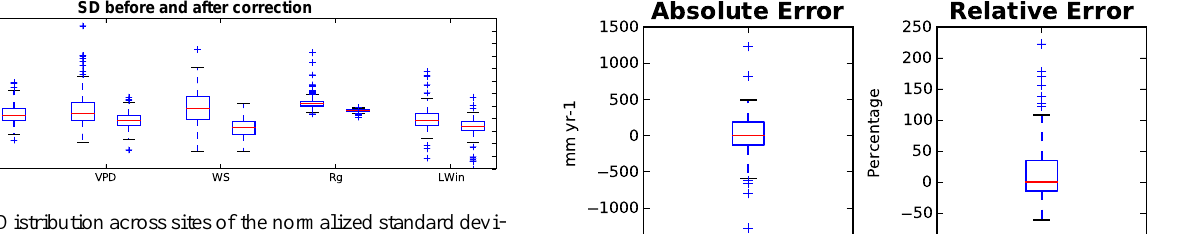
Figure 2. Distribution across sites of the normalized standard devi- ation of the ERA-I data before (left) and after (right) bias correction for air temperature, vapour pressure deficit, wind speed, global ra- diation and longwave incoming radiation. The box extends from the Figure 3. Distribution across sites of the error on the mean an- lower (25%) to upper quartile (75%) values of the data, with a red nual precipitation as measured at FLUXNET stations when using line at the median. The whiskers extend from the box to show the the ERA-I product, in absolute (mmyr − 1 , left panel) and relative range of the data within 1.5 (25–75%) data range. Outliers are values (%, right panel). The box extends from the lower (25%) to × marked by crosses beyond the end of the whiskers. upper quartile (75%) values of the data, with a red line at the me- dian. The whiskers extend from the box to show the range of the data within the 1.5 (25–75%) data range. Outliers are marked by × crosses beyond the end of the